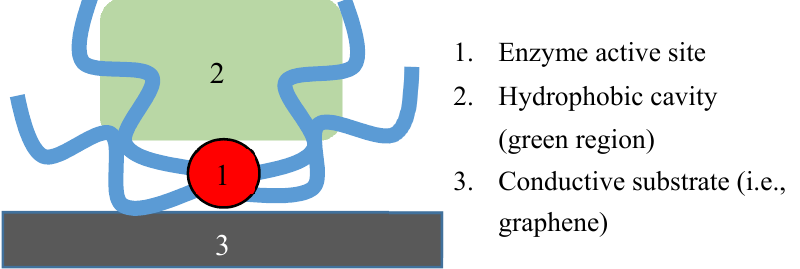
Figure 3. General enzyme features relevant to sensing technology.